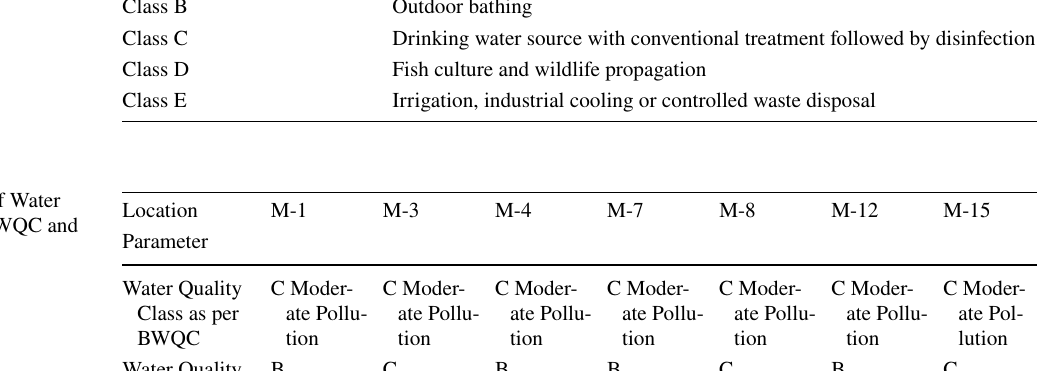
Table 7 Use of water according to class as per ISI-IS 2296–1982